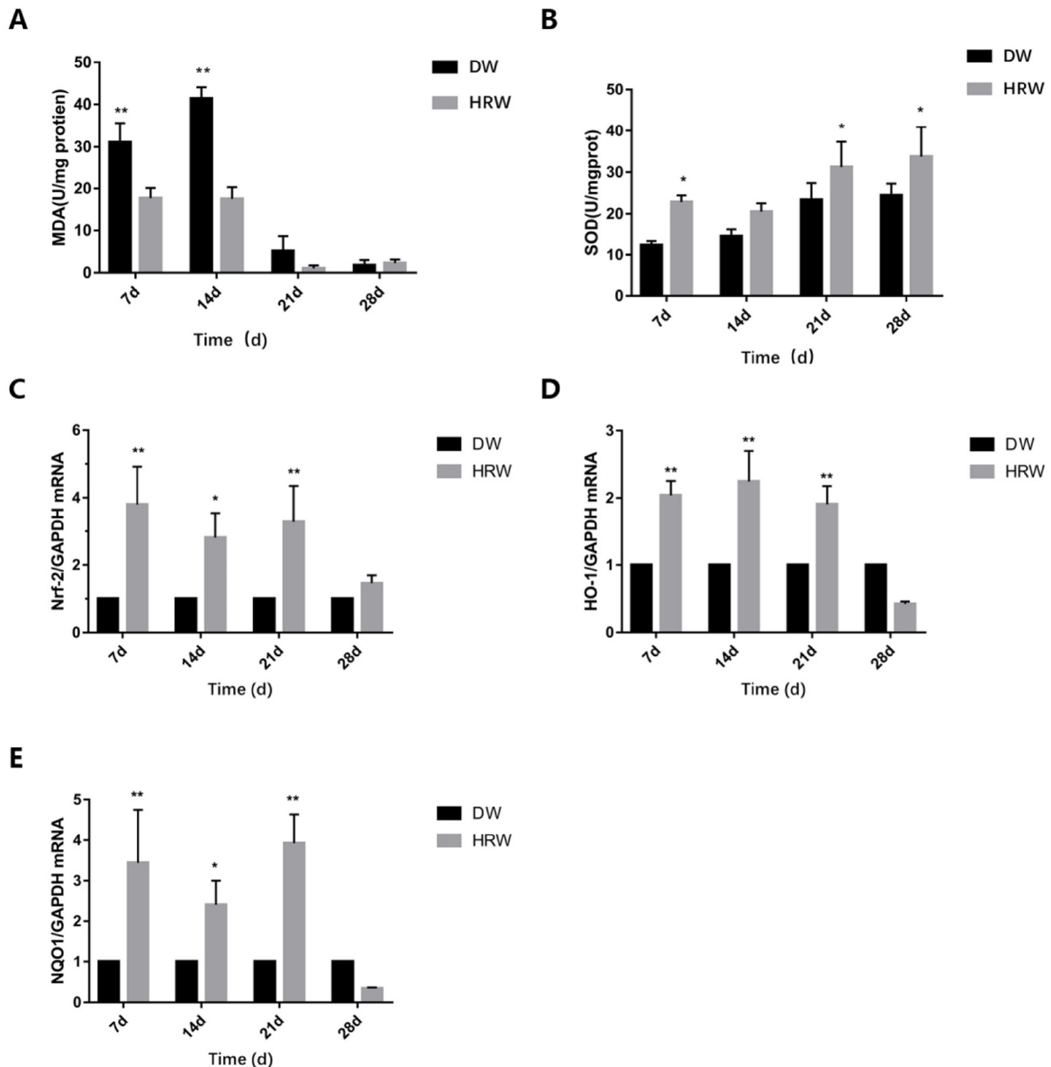
Figure 7. ( A ) MDA and ( B ) SOD activity of sample was determined using test kits. Relative ( C ) Nrf-2, ( D ) HO-1 and ( E ) NQO-1 mRNA levels were measured by TaqMan real-time PCR. * p < 0.05, ** p < 0.01. Table 5. The level of MDA (U/mg) in DW and HRW groups at days 7, 14, 21, and 28. ** p < 0.01. Time